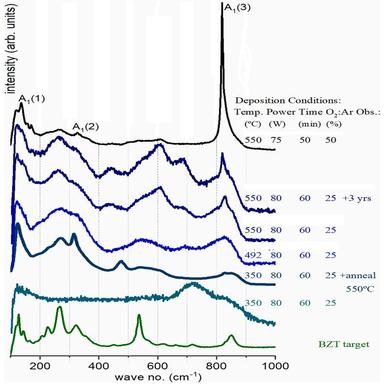
Raman spectra of BZT target and thin films deposited at different conditions, treatments and ageing.